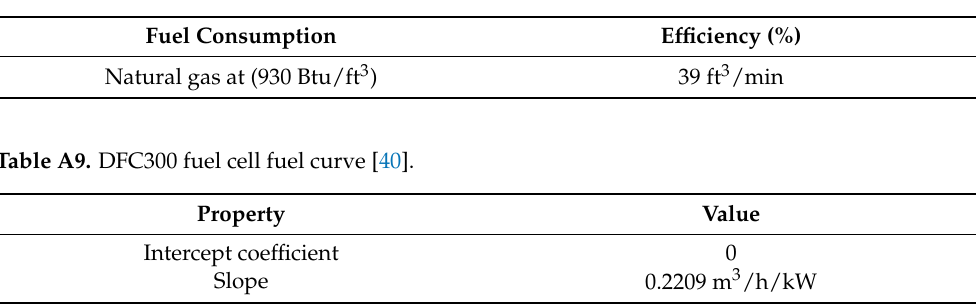
Table A8. DFC300 fuel cell efficiency [40].